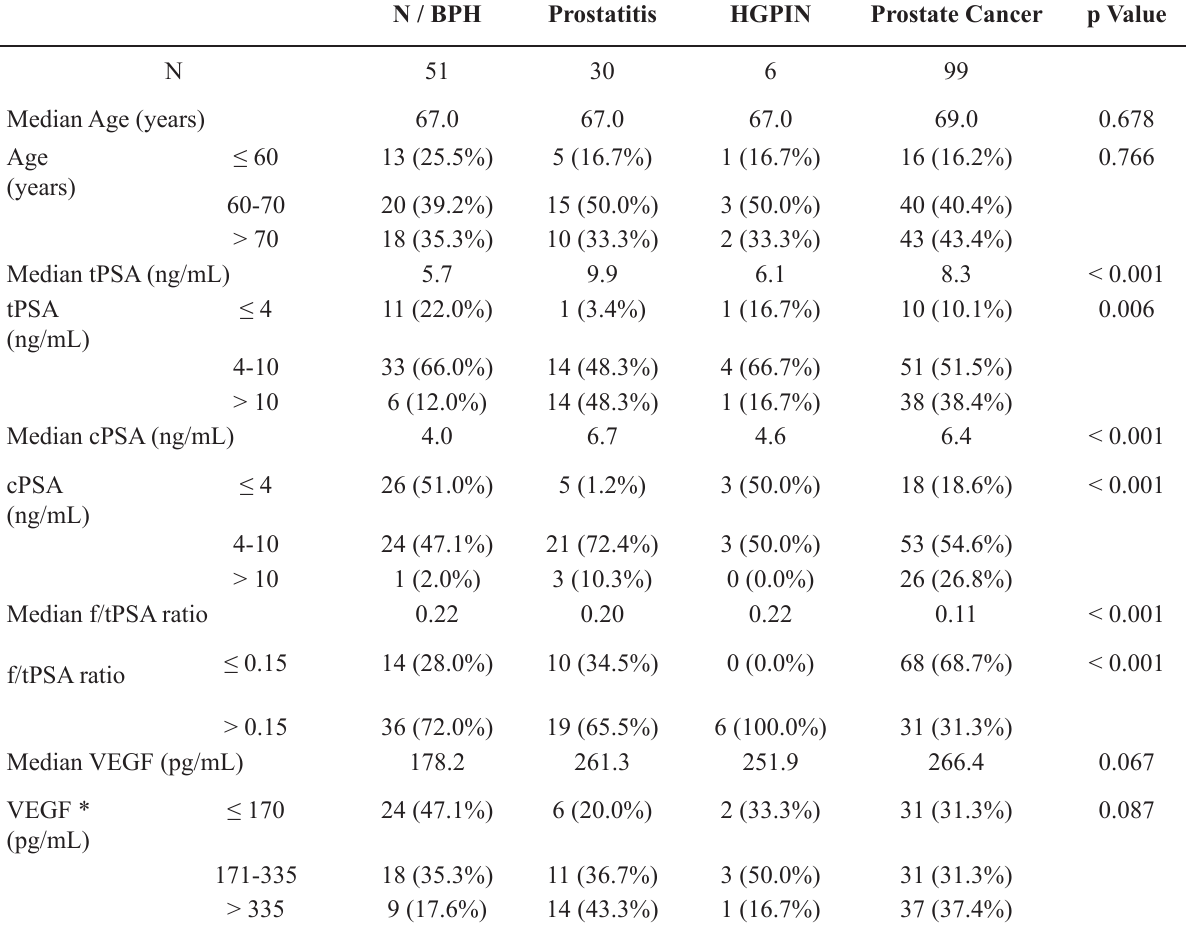
Table 1 – Characteristics of the participants stratified by prostatic